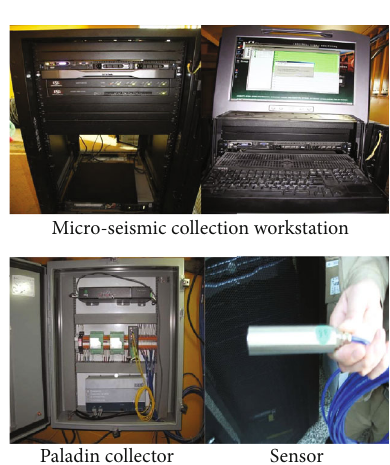
Figure 16: Workstation sampling instrument sensor